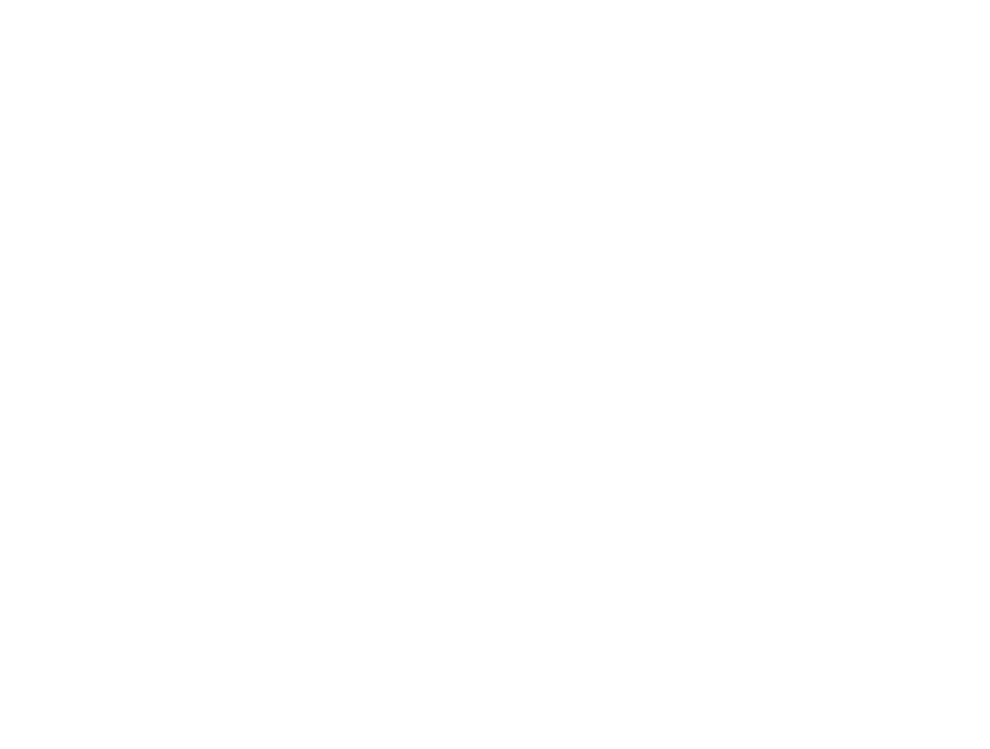
dinucleotides and black circles represent methylated CpG dinucleotides. Gray circles represent CpG sites that were converted to CpA or TpA, as occasionally can be observed. Each row is derived from an individual subclone. Percent of CpG methylation appears below the cell